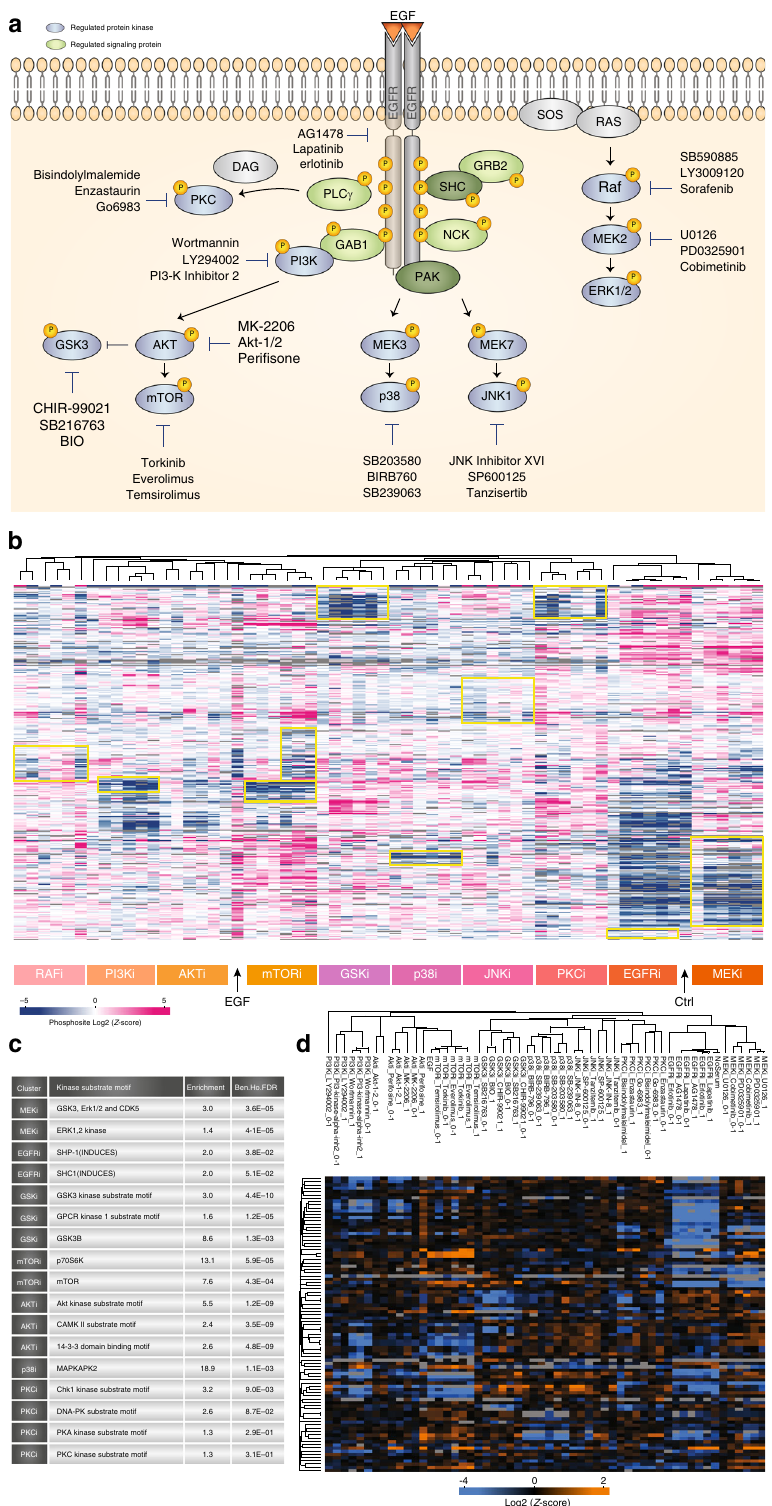
Fig. 5 Kinase inhibitor screen. a Experimental overview of kinase inhibitors used. b Hierarchical clustering of averaged site intensities from six independent measurements. c Fisher Exact test of overrepresented kinase motifs. d Clustering analysis of known substrates and individual